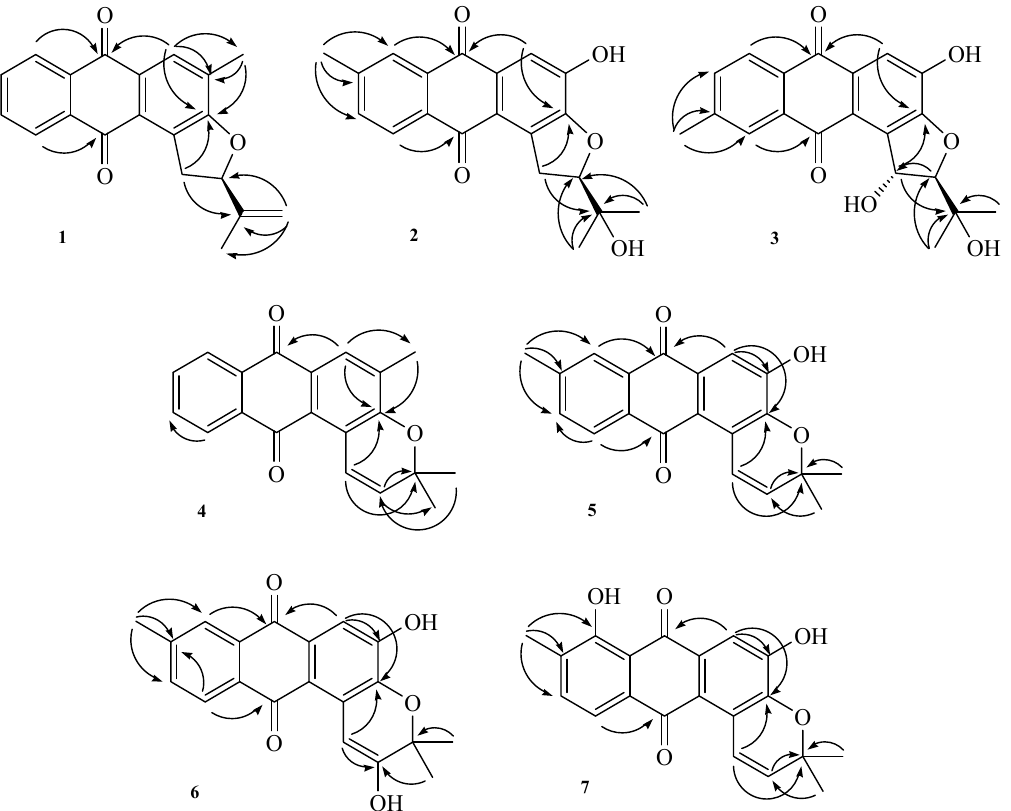
Figure 1. Structures of anthraquinones 1–7 isolated from H. diffusa.